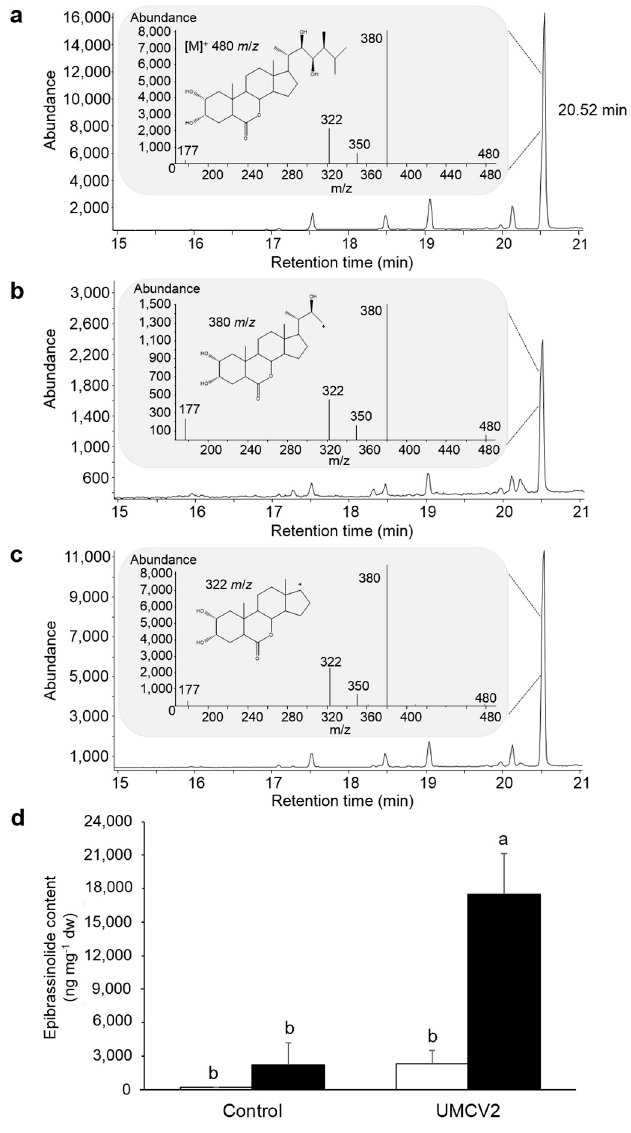
Figure 6. Identification of brassinolide in Medicago truncatula by GC-MS. ( a ) Total ion chromatogram of the epibrassinolide standard, indicating the retention time of the phytohormone and the electron impact mass spectrum during the SIM analysis. ( b ) Total ion chromatogram and mass spectrum obtained from the control plants grown under conditions of iron (Fe) deficiency. ( c ) Total ion chromatogram and mass spectrum obtained from plants grown under conditions of Fe deficiency and exposed to volatiles from A. agilis UMCV2. ( d ) Brassinolide content in plants grown under Fe-su ffi cient (white bars) and -deficient (black bars) growth conditions. Data shown are means ± standard error (n = 3). Di ff erent letters indicate significant di ff erences ( p ≤ 0.05) among treatments determined with two-way ANOVA followed by a Tukey’s test.